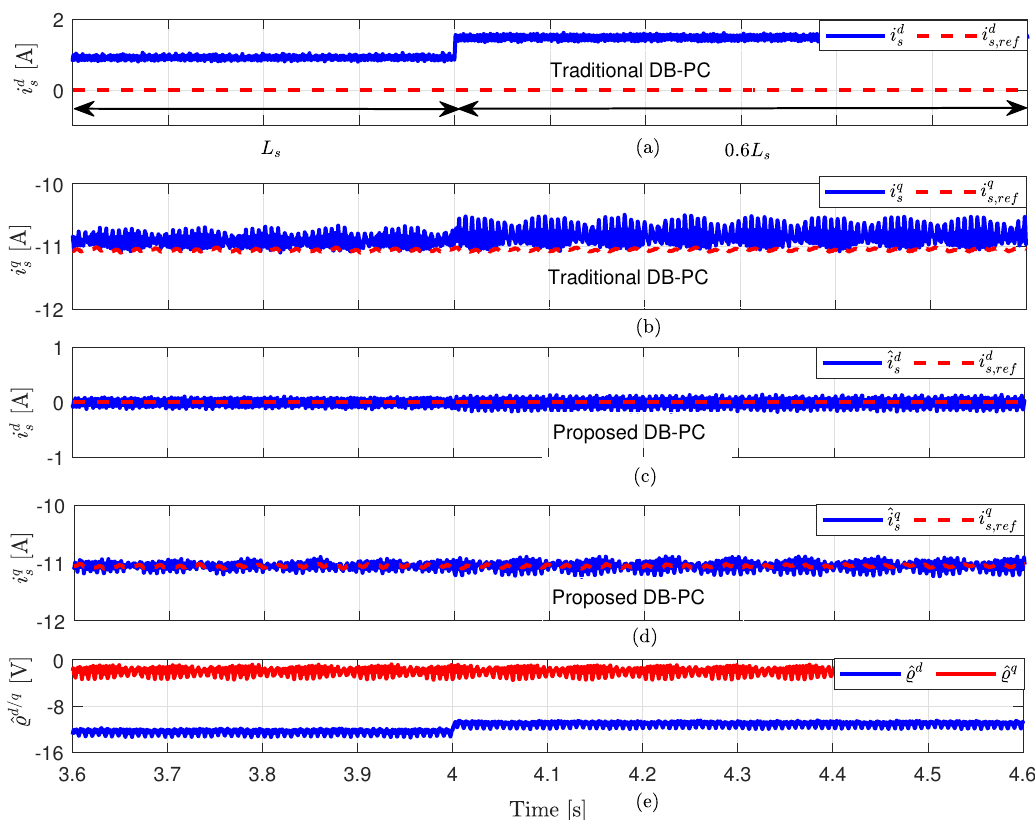
Figure 11. Experimental results of the proposed DB-PC and traditional one at mismatches in the stator inductance L s of the PMSG: ( a ) actual and reference d -axis currents, ( b ) actual and reference q -axis currents, ( c ) observed and reference d -axis currents, ( d ) observed and reference q -axis currents, and ( e ) observed total disturbance for d and q